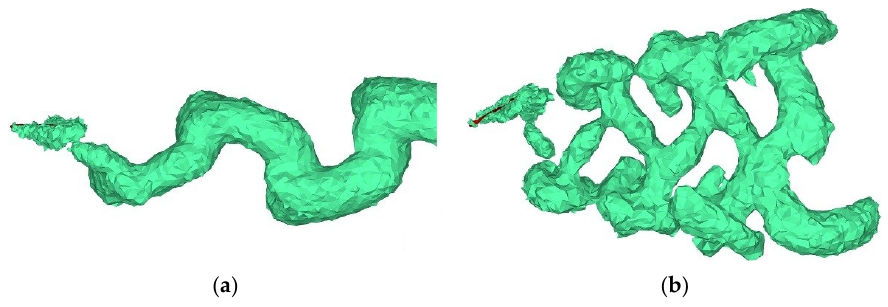
Figure 15. Vortex pattern in the wake: ( a ) St = 0.3; ( b ) St = 0.5.